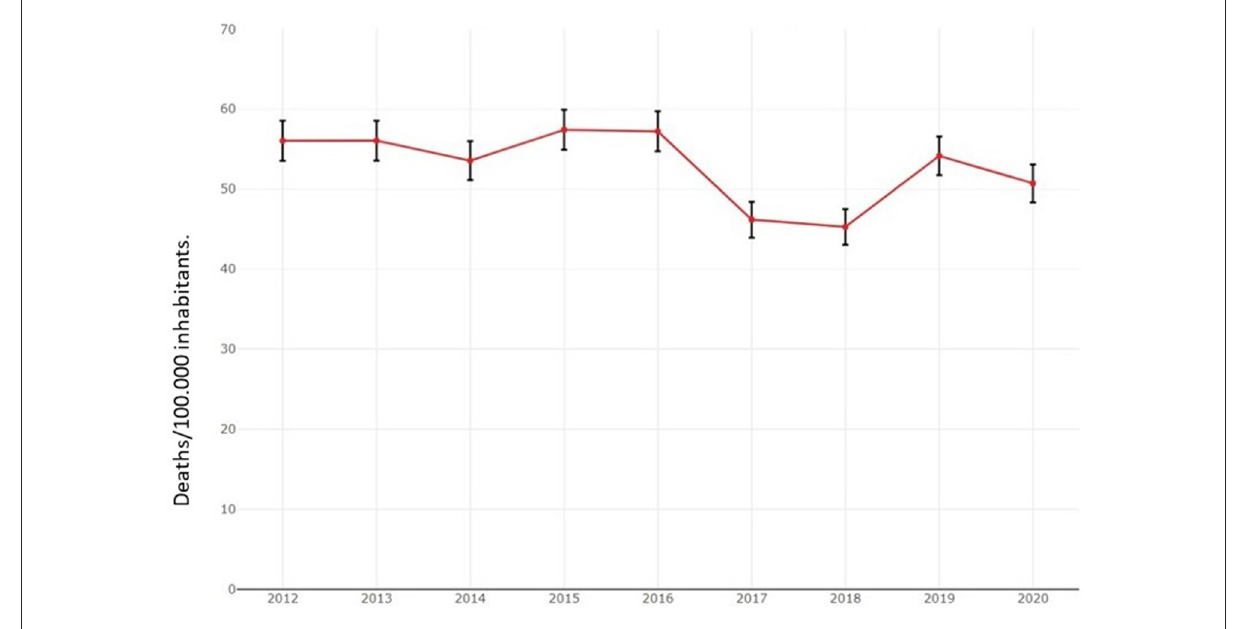
FIGURE1 Mortality progress due to stroke in Uruguay from 2012 to